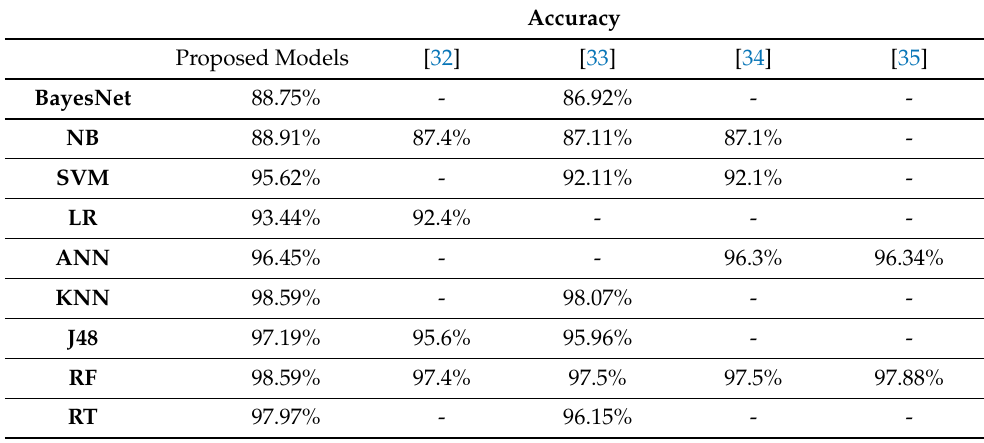
Table 5. Model comparison in terms of accuracy with 10-fold